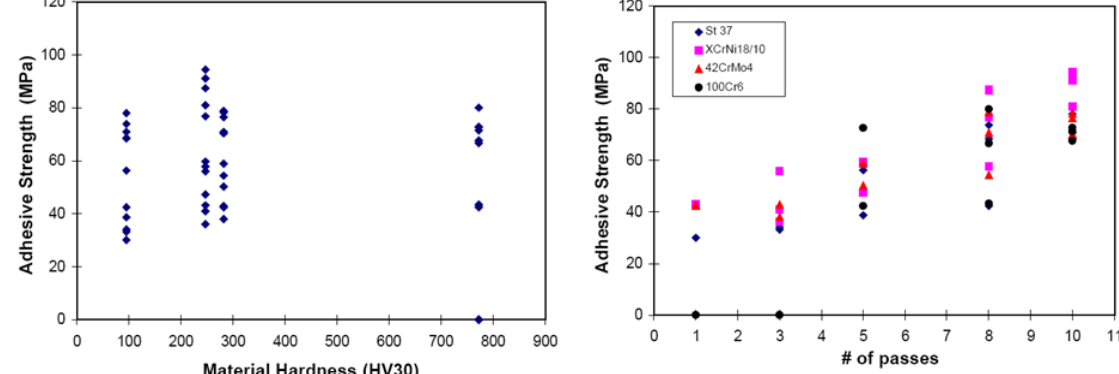
Figure 8: Tensile adhesive strength as a function of the substrate materials hardness and number of grit blast passes